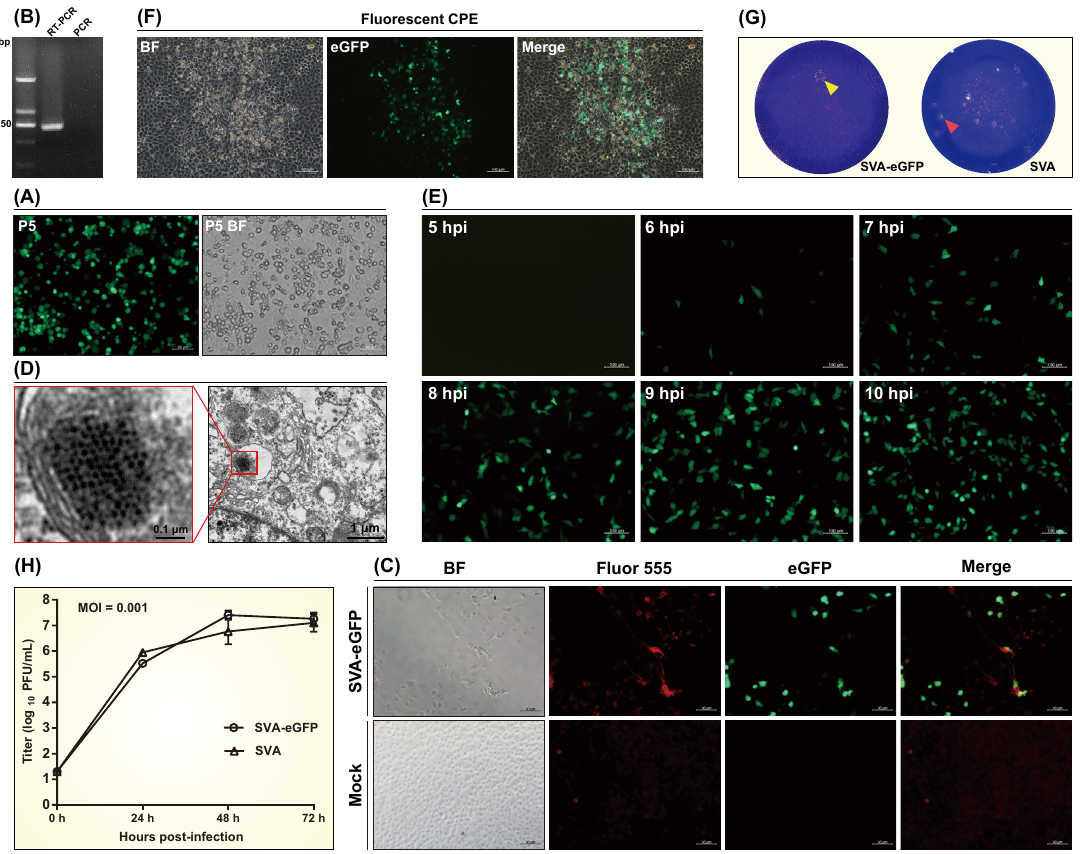
Figure 2. Identification and characterization of rescued rSVA-eGFP. BSR cell monolayer infected with P5 rSVA-eGFP at 24 hpi ( A ). RT-PCR analysis of rSVA-eGFP using the F1 / R1 primer pair ( B ). Indirect immunofluorescence assay of rSVA-eGFP-infected BSR cells using the anti-VP1 MAb (primary antibody) and the Alexa Fluor ® 555 conjugate (secondary antibody) ( C ). Observation of ultrathin section of rSVA-eGFP-infected BSR cell by transmission electron microscope ( D ). BSR cell monolayers infected with rSVA-eGFP at 5, 6, 7, 8, 9 and 10 hpi ( E ). Fluorescent cytopathic e ff ects (CPE) on cell monolayer infected with rSVA-eGFP at 72 hpi ( F ). Plaque morphology of the rSVA-eGFP (yellow arrowhead-marked), compared with that of the rSVA (red arrowhead-marked) ( G ). Growth curve of the rSVA-eGFP, compared with that of the rSVA ( H ). The data represent the mean ± SD for three independent